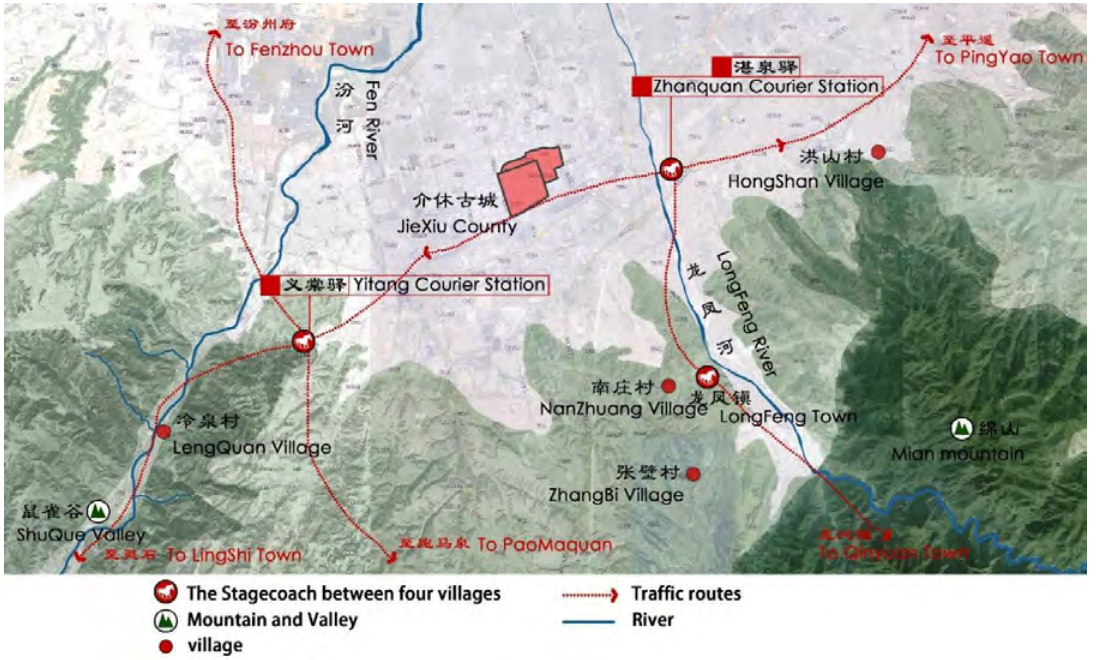
Figure 2 Business lines in the late Qing